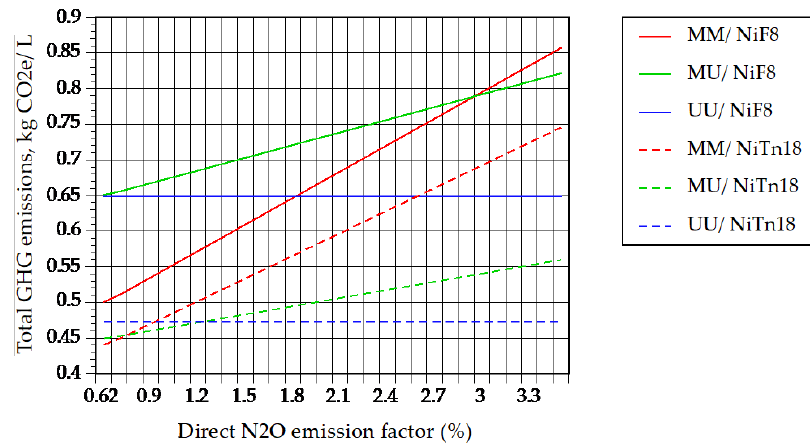
Figure 5. Sensitivity analysis of total greenhouse gas (GHG) emissions to the direct N 2 O emission factor from mulched soil. The emission factor is the percentage of N 2 O-N out of the applied N; 0.62% was the default emission factor value in the present study. MM, mulching at planting and every ratooning; MU, mulching only at planting; UU, untreated, i.e., no mulching at all. NiF8, a conventional cultivar; NiTn18, a cultivar characterized by improved yielding capacity and cold tolerance.